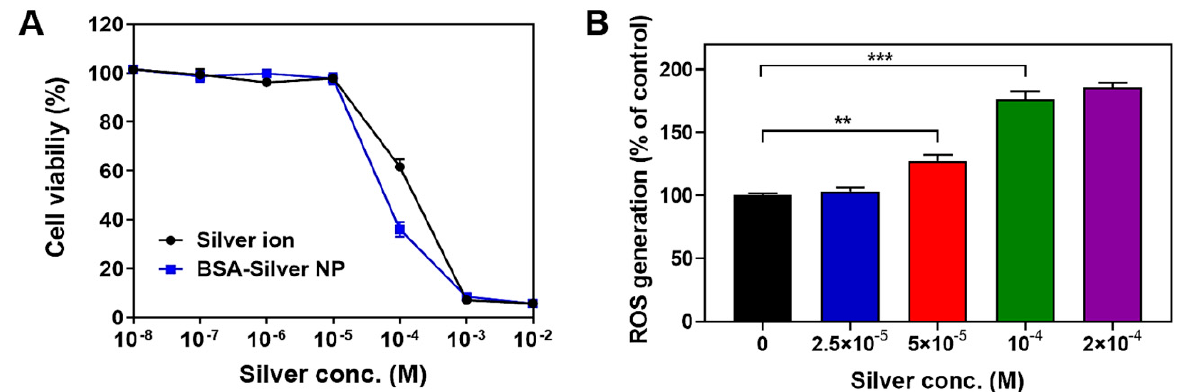
Figure 3. Cytocidal activity of BSA-Silver NPs: ( A ) cell viability profiles of B16F10 cells after treatment of either silver ions or BSA-Silver NPs. ( B ) Reactive oxygen species (ROS) generation assay results. The statistically significant differences in the cytotoxicity levels were compared by 1-way ANOVA (Tukey’s multiple comparison test as the post hoc test). ** p < 0.01, *** p < 0.001 vs. PBS control. (BSA-Silver NP: BSA-coated silver nanoparticles).